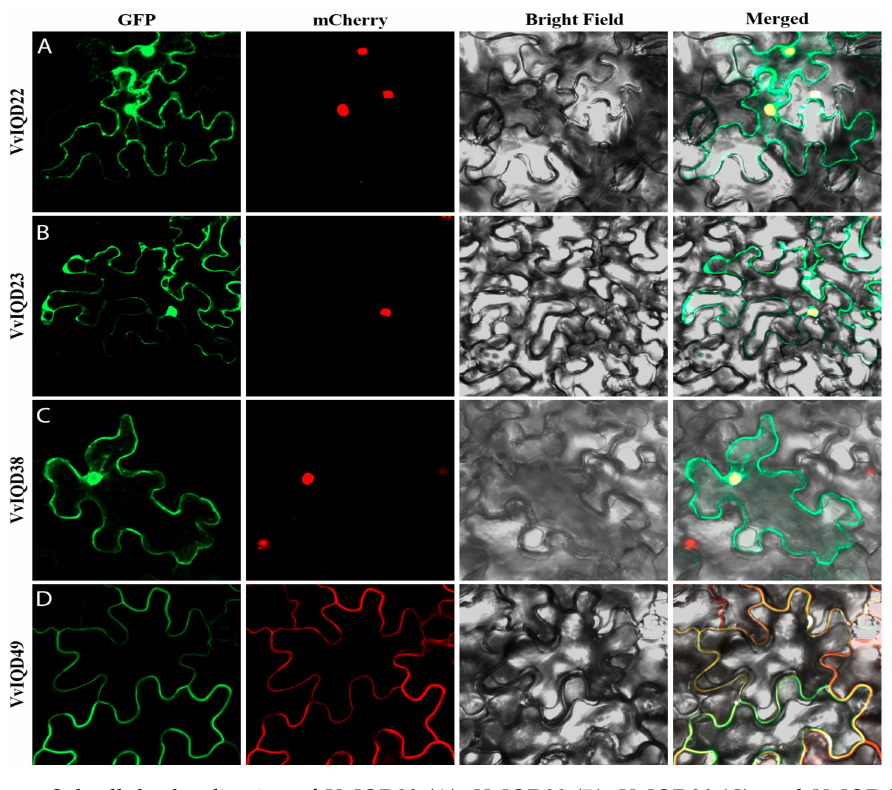
Figure 5. Subcellular localization of VvIQD22 ( A ), VvIQD23 ( B ), VvIQD38 ( C ), and VvIQD49 ( D ) in nucleus and membrane, using the N. benthamiana epidermal cells.